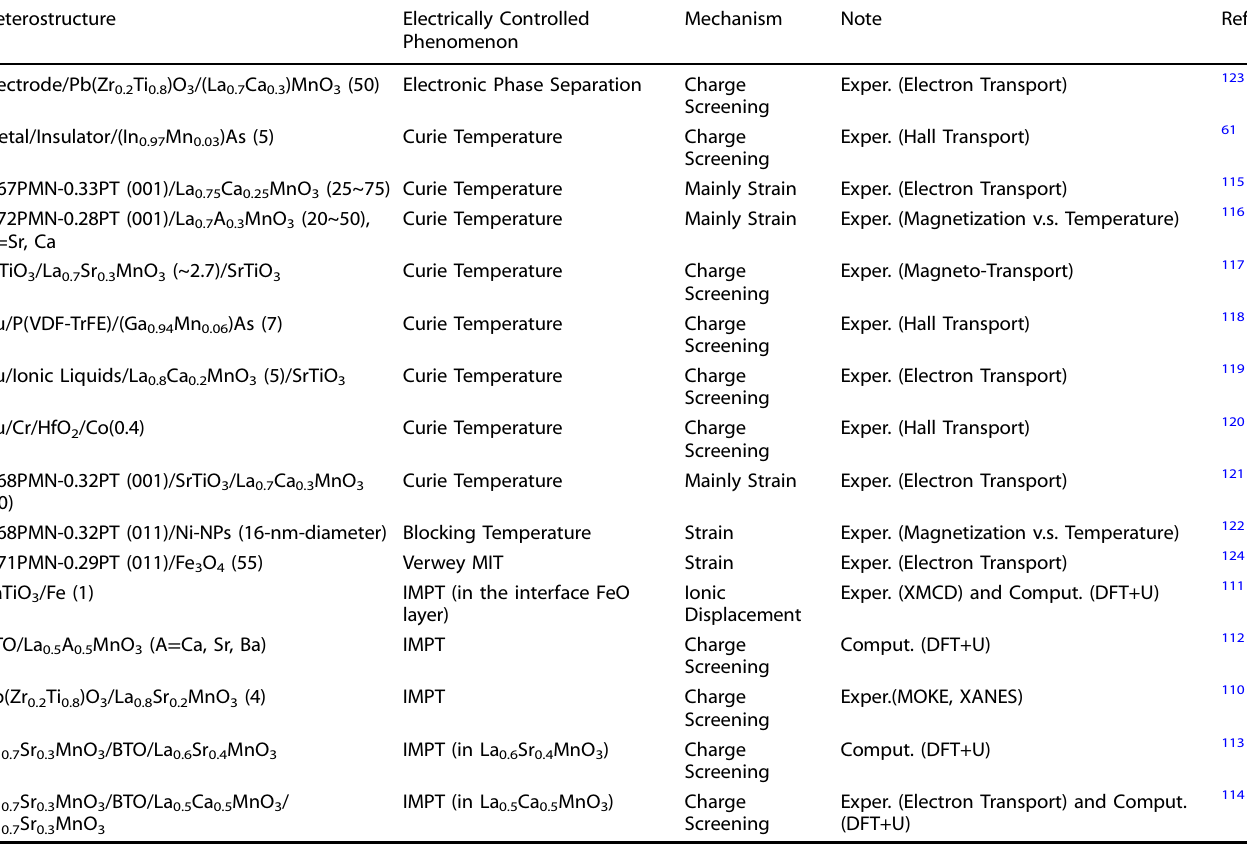
Table 1. Some experiments (Exper.) and computations (Comput.) on magnetoelectric coupling via electrically controlled magnetic phase transitions in horizontal magnetoelectric heterostructures